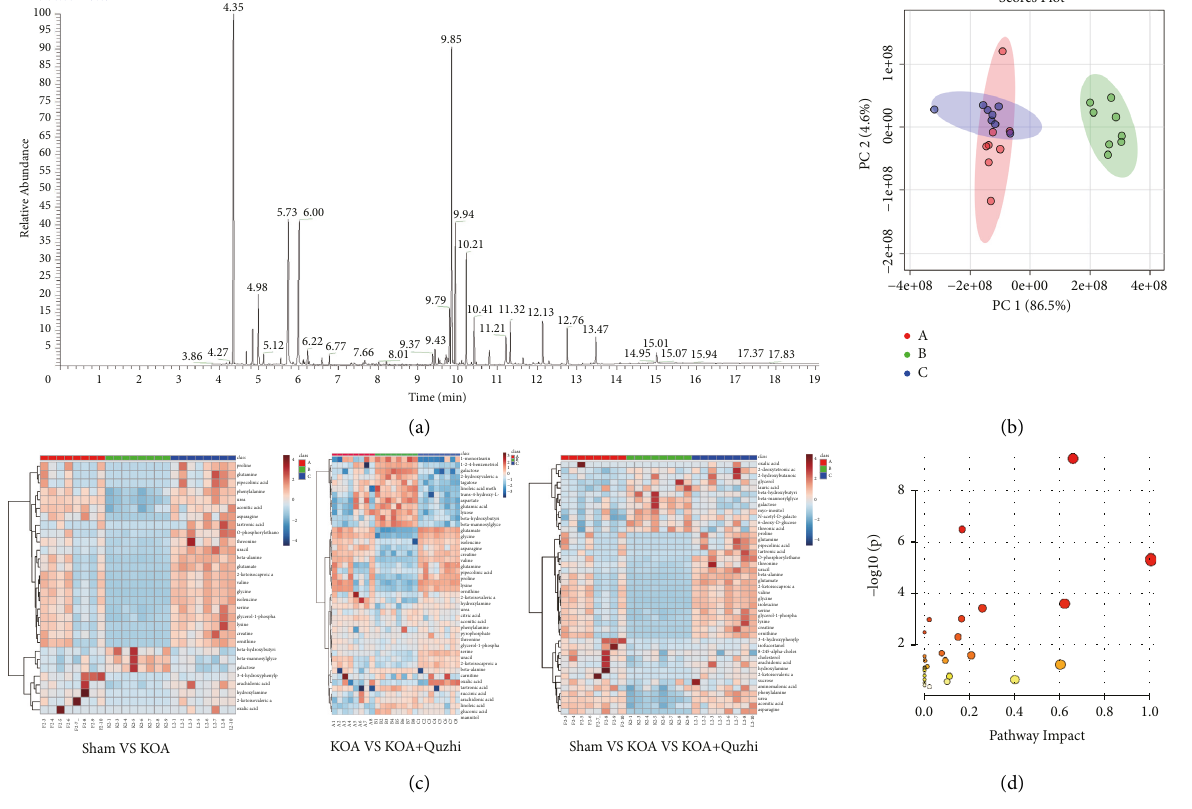
Figure 4: The identification of different metabolites after Quzhi decoction treatment in KOA rats. (a) Total ion chromatogram (TIC) of the methanol extract acquired by GS-MS; (b) PLSDA of metabolites in the KOA rats. Each point in the figure represents a sample, and all the sample points are distributed in the circular region. N � 8; (c) heatmap of identified differential metabolites among the sham, KOA and KOA+Quzhi groups; (d) bubble chart of metabolic pathways from significant metabolites. Node size is based on impact values, and node color is based on − log10 ( p ) values.